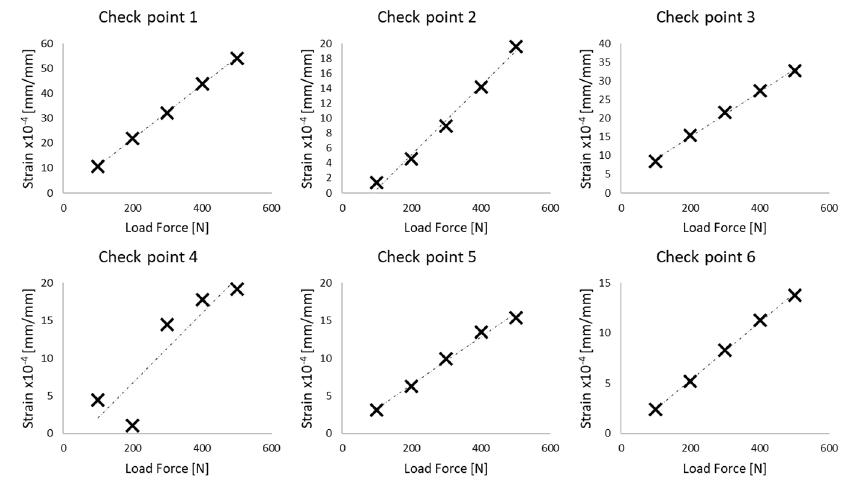
Figure 5. Validation of elaborated FE model for six points [25].